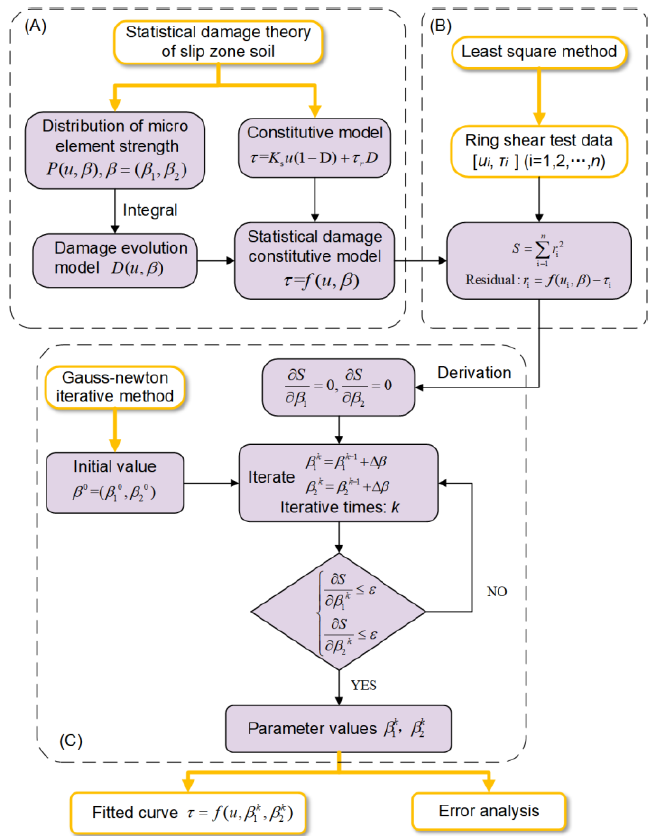
Figure 6. Fitting flow chart of shear constitutive model of slip zone soil. ( A ) Construction of statistical damage constitutive model; ( B ) Least square fitting method; ( C ) Iterative method for solving model parameters.